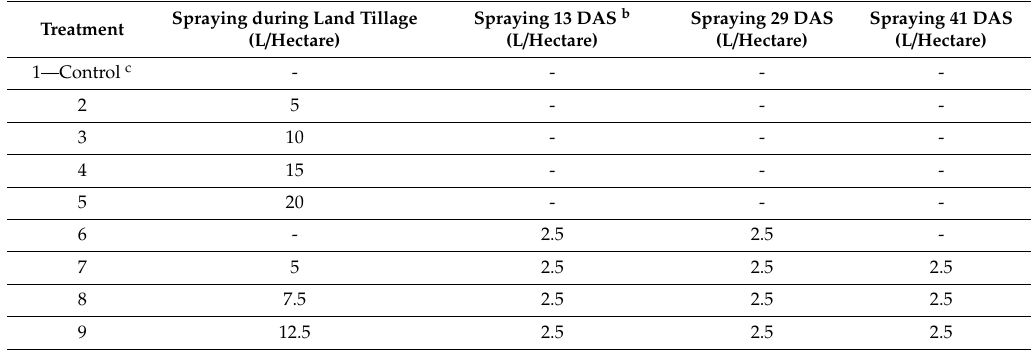
Table 2. Azoxystrobin treatments in the spraying field experiment (Neot Mordechai, spring 2018) a .